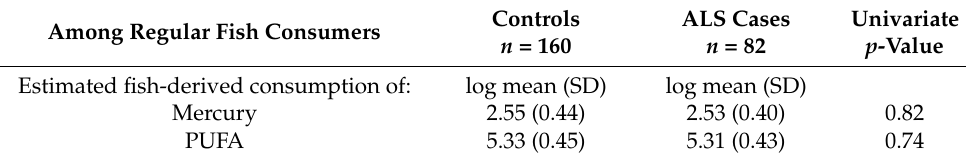
Among Regular Fish Consumers